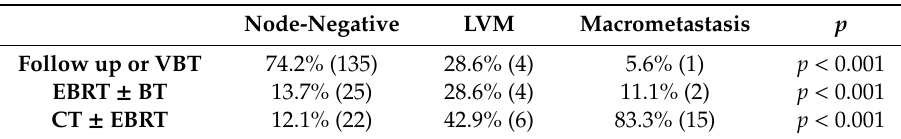
Table 3. Adjuvant therapy by nodal status. VBT: vaginal brachytherapy; EBRT: external beam radiotherapy; CT: chemotherapy.